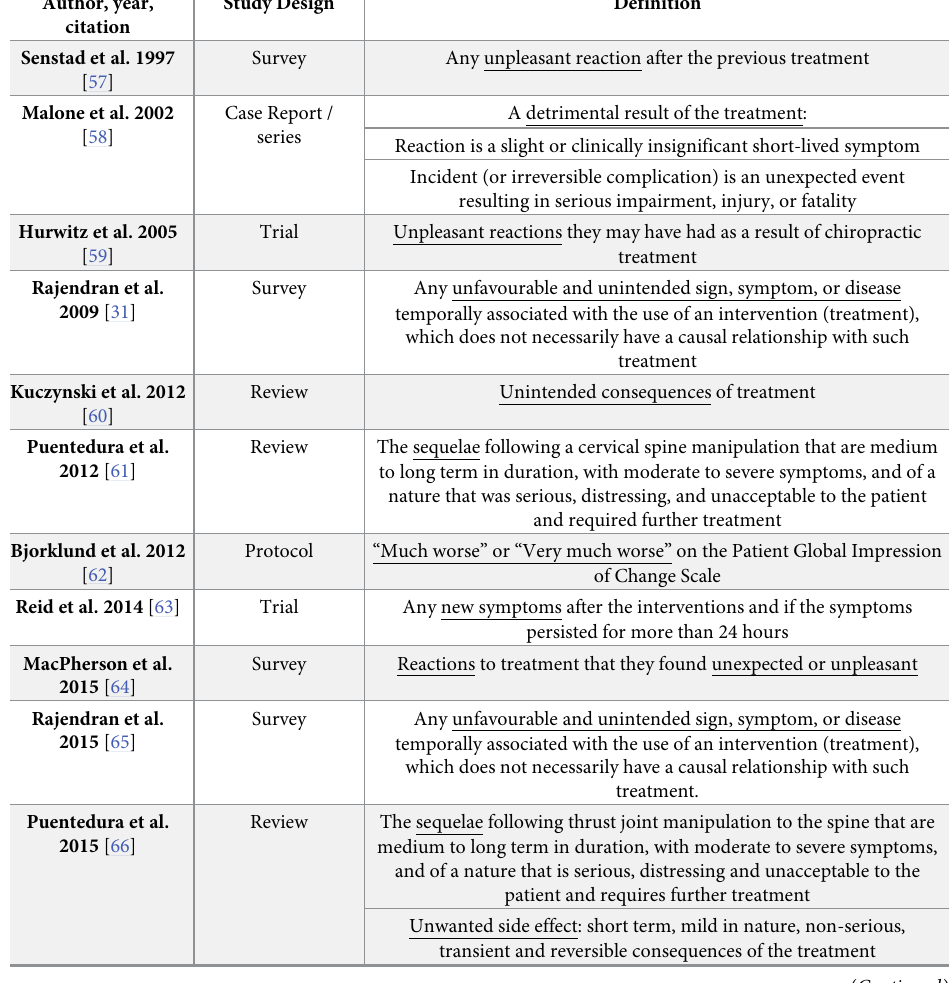
Table 3. Studies providing direct adverse event definition only (n =